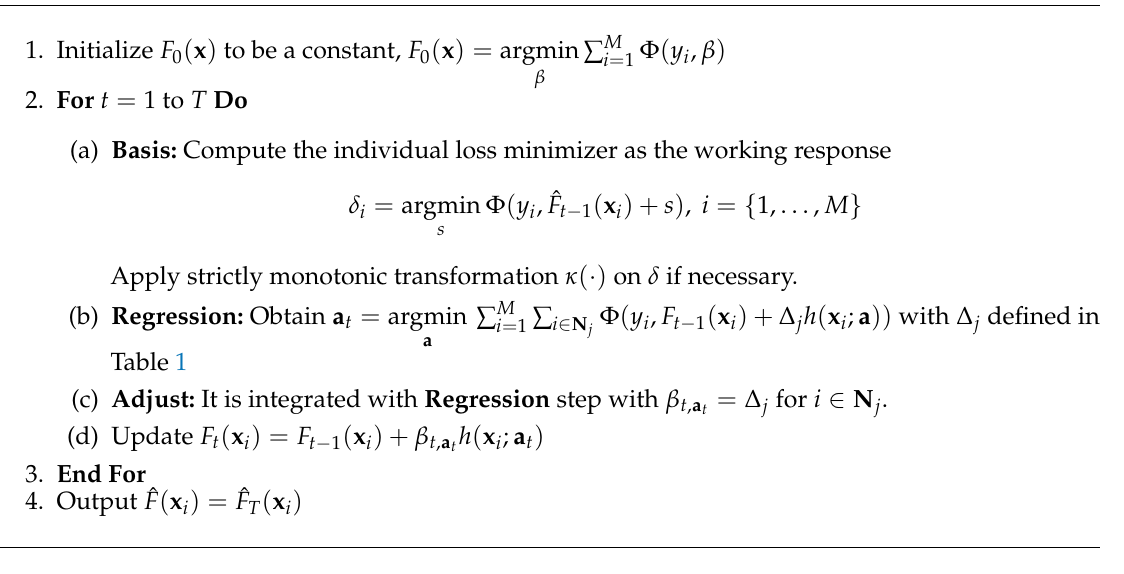
Algorithm 1 Delta boosting for a single parameter